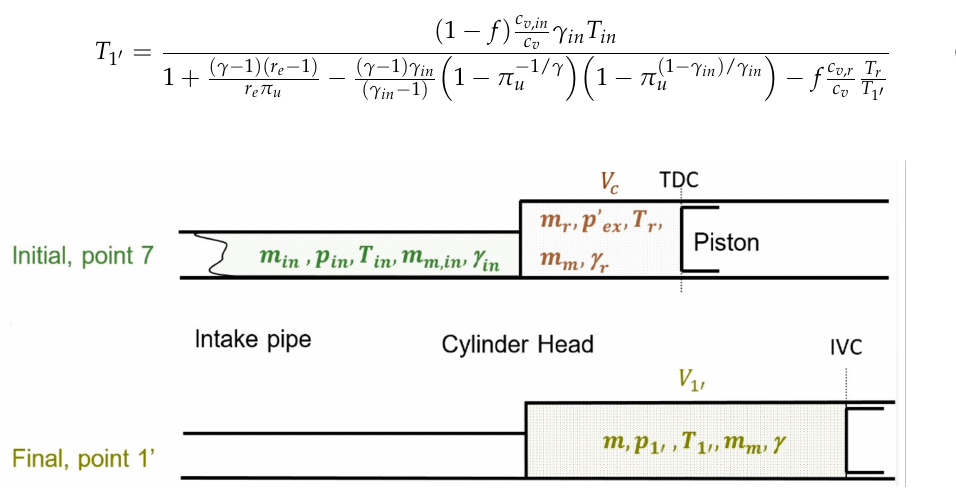
Figure 2. Initial and final states of the intake